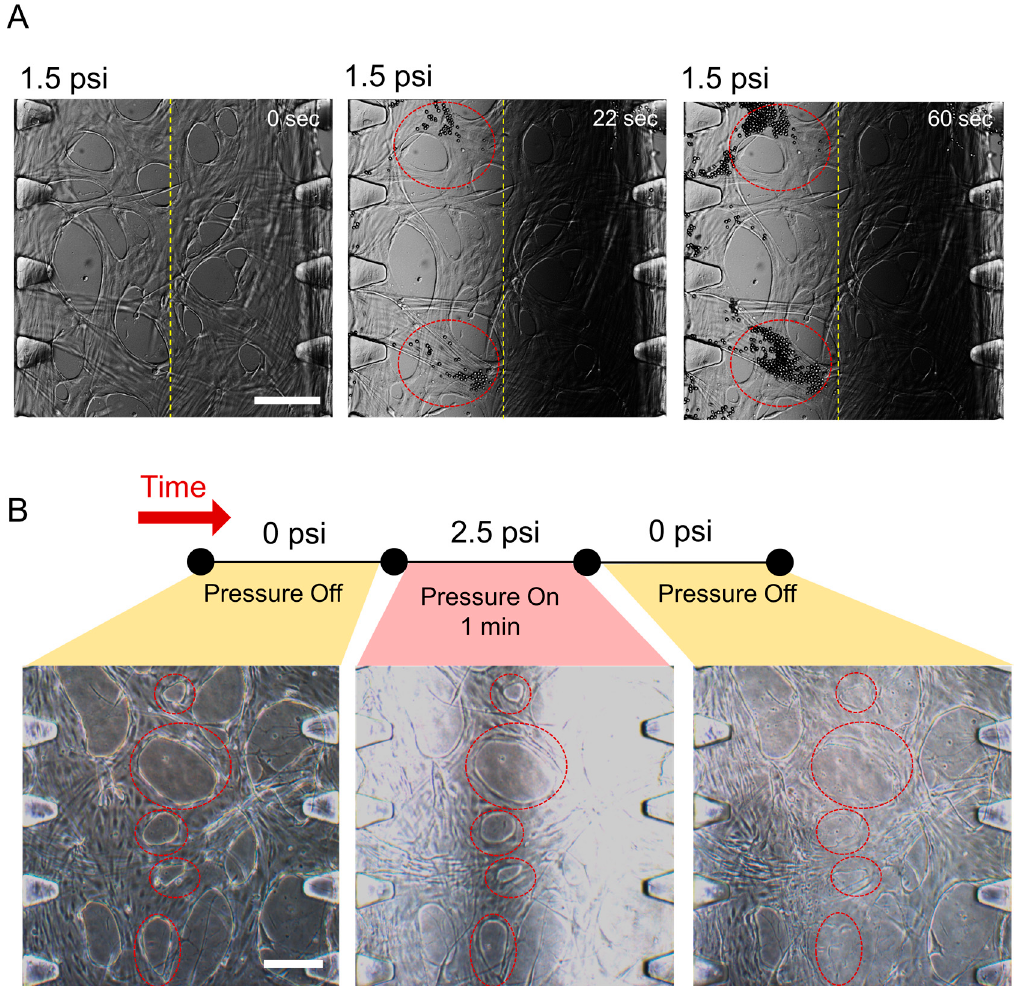
Figure 4. Applying compressive stress to the perfusable microvessels. ( A ) Microbeads (7 μ m) were introduced into the microvascular network when the microvascular network was exposed to 1.5 psi. Scale bar: 100 μ m ( B ) Bright-field images of the microvascular network in response to air pressures of 0 psi, 2.5 psi, and after releasing the applied pressure. Scale bar: 100 μ m.